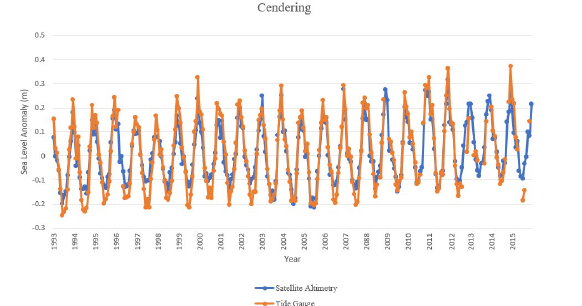
Figure 3. Graph of sea level anomaly changes at Cendering station from 1993 to 2015